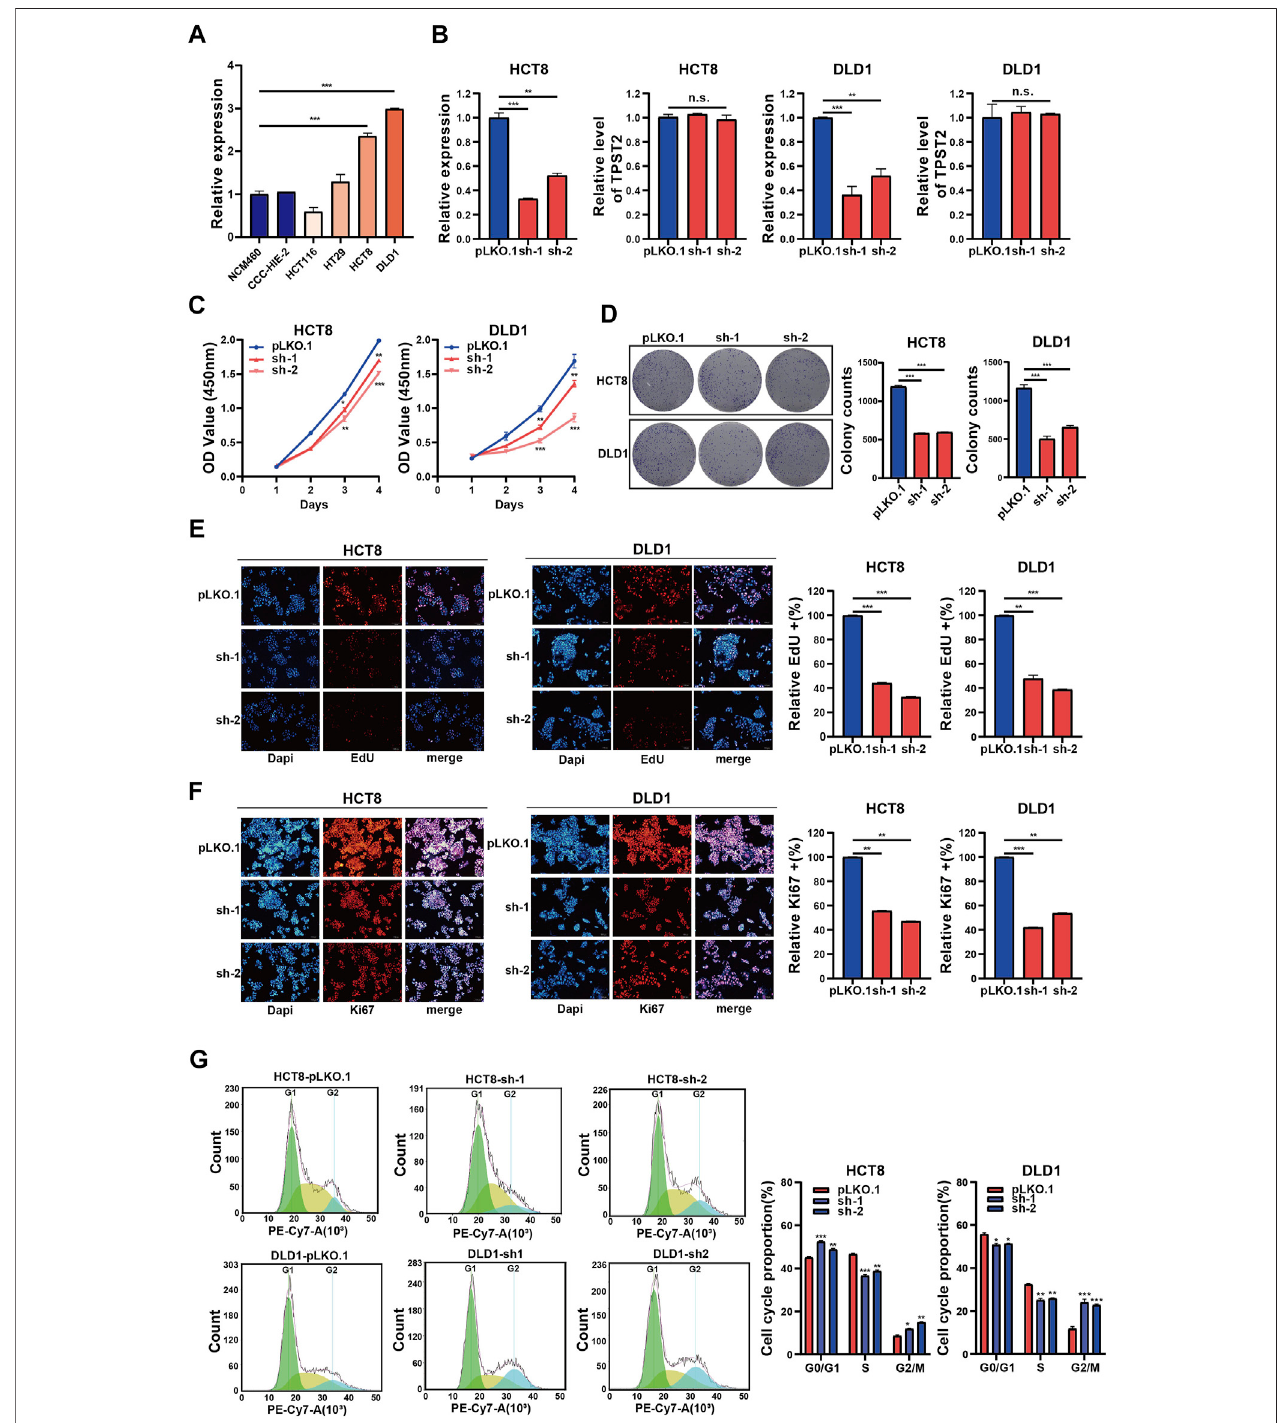
FIGURE 2 | Circ_0062682 knockdown inhibits CRC cell proliferation and cell cycle progression in vitro . (A) The relative expression of circ_0062682 in different cell lineswasdetectedbyqRT-PCR. (B) Theinhibitoryef fi ciencies oftwoshRNAson theexpression ofcirc_0062682and itshost geneTPST2 were evaluatedbyqRT-PCR in CRC cells. (C,D) CCK-8 and colony formation assays were performed to evaluate the effects of circ_0062682 knockdown on the proliferation of CRC cells. (E,F) The effects of circ_0062682 knockdown on CRC cell proliferation were assessed by EdU (E) and Ki67 staining (F) . (G) The effects of circ_0062682 knockdown on the cell cycle progression of CRC cells. * p < 0.05; ** p < 0.001; *** p < 0.001.